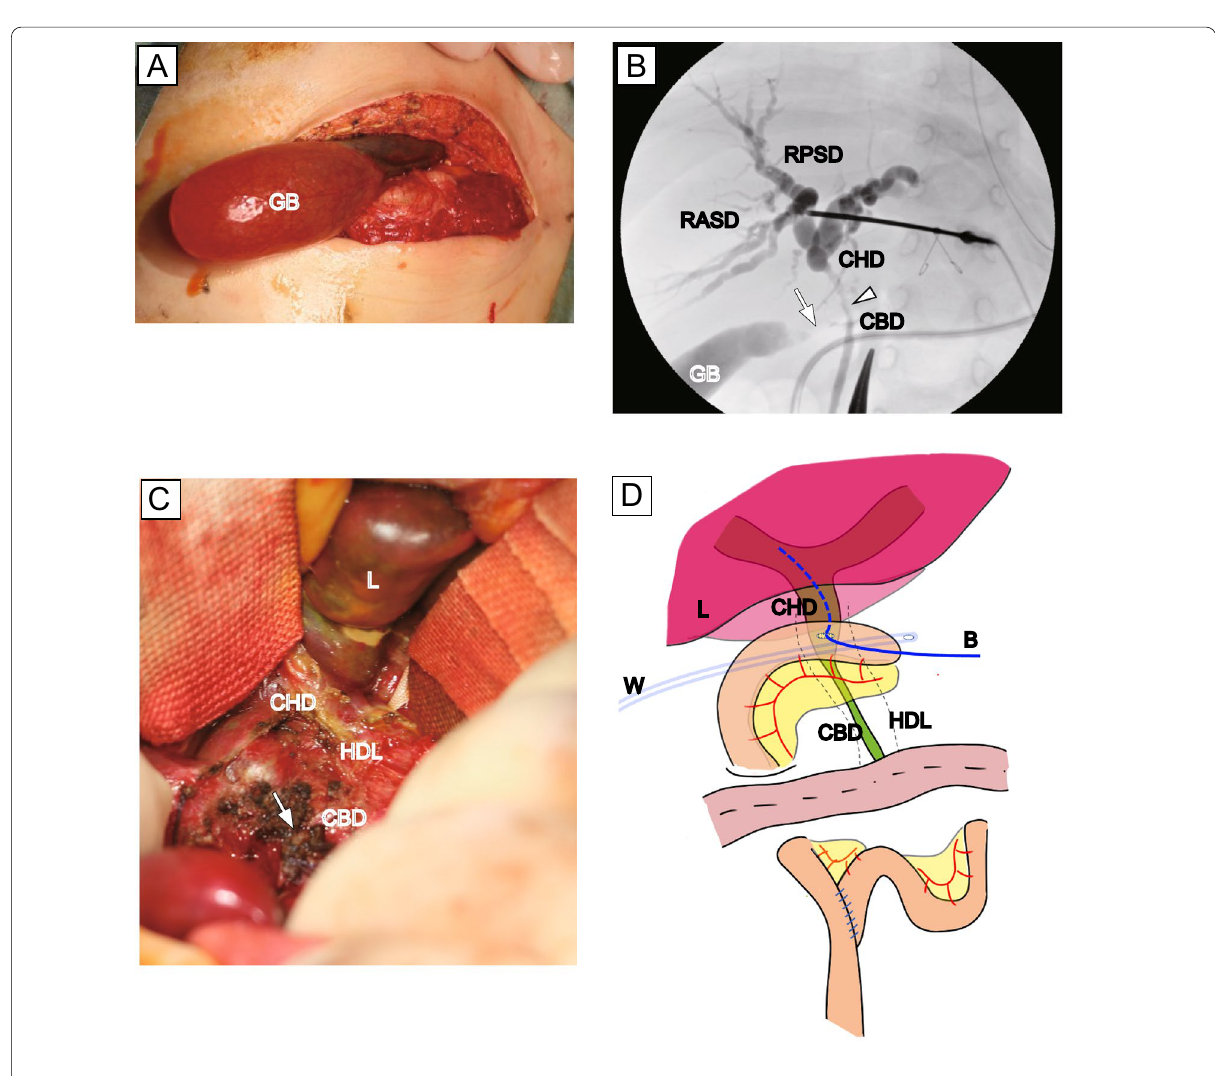
Fig. 2 Intraoperative findings of second operation. A The GB appears quite distended with white bile. B Intraoperative cholecystography revealed that the CD is completely obstructed (arrow), and intraoperative intrahepatic cholangiography revealed narrowing of the bile duct around the junction of the CD along the hepatoduodenal ligament (arrowhead). CBD, common bile duct; CD, cystic duct; CHD, common hepatic duct; GB, gallbladder; RASD, right anterior segment duct; RPSD, right posterior segment duct. C Area around the junction of the CD and CHD. The CD was resected as distally as possible (arrow). CD, cystic duct; CHD, common hepatic duct; HDL, hepatoduodenal ligament. D Hepaticojejunostomy performed in Roux-en-Y fashion. The jejunum was anastomosed with the ventral wall of the CHD. A 4-Fr hepatic drainage tube was placed in Witzel fashion (B) and a 15-Fr drainage tube was inserted via the Winslow foramen